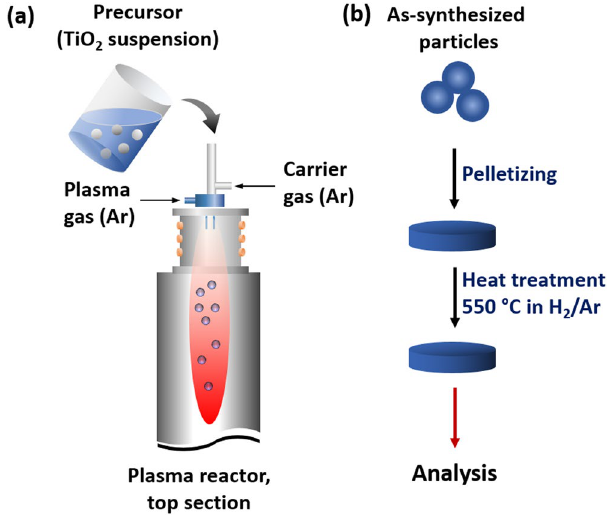
Figure 1. Illustration of ( a ) TiO x NP preparation using RF induction thermal plasma method, and ( b ) post- synthesis heat treatment to improve the electrical